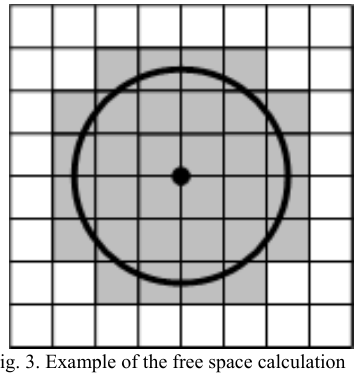
Fig. 3. Example of the free space calculation